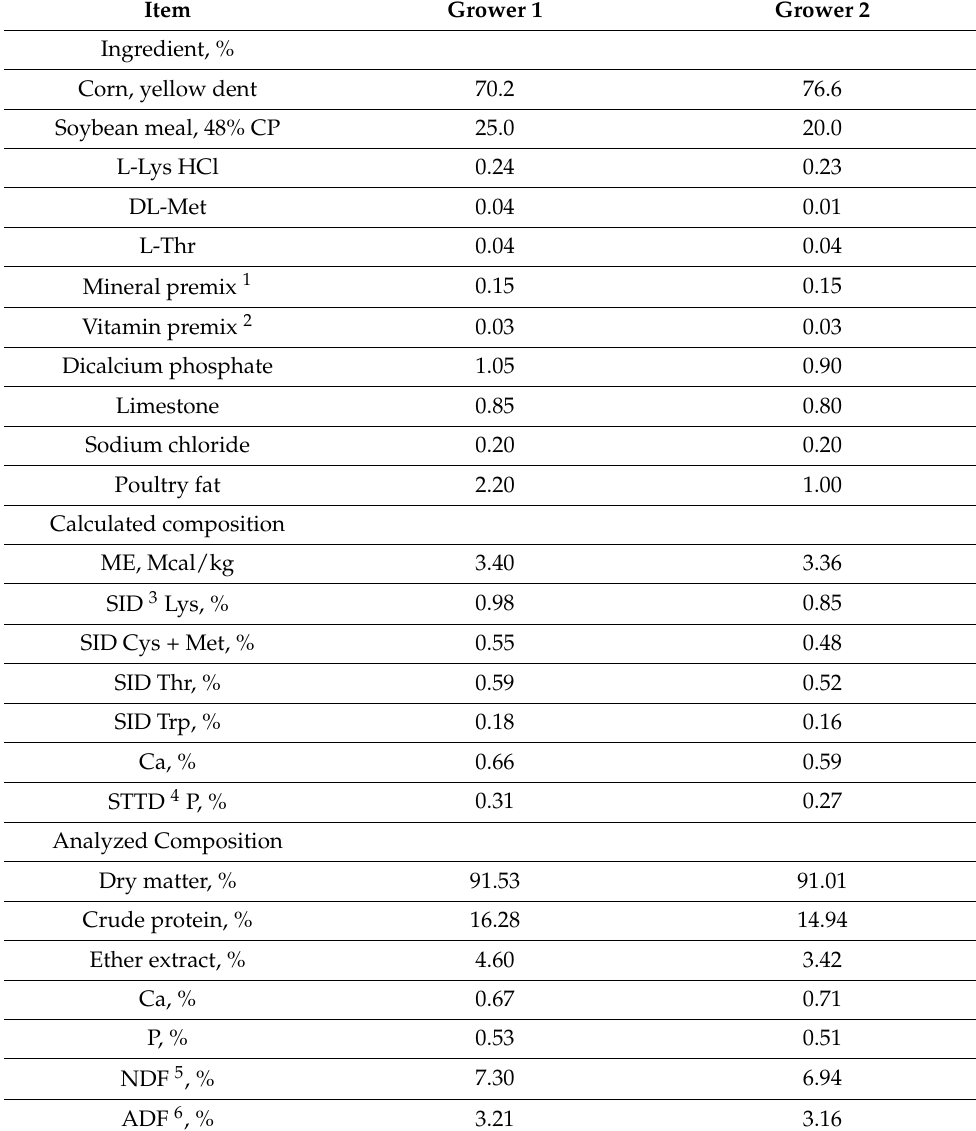
Table 2. Composition of basal diets (Exp. 2; as-fed